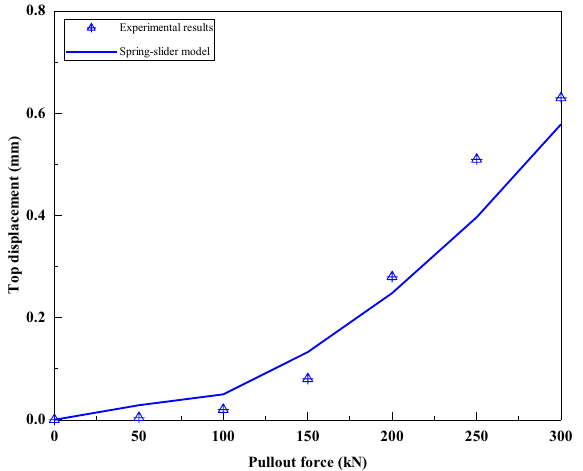
Figure 21. Comparison of bolt top displacement predicted by spring-slider model and test